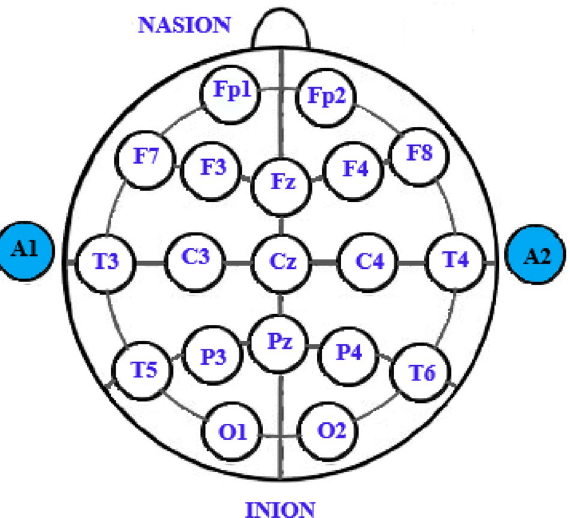
Figure 7. The schematic image of 21 electrodes on the head (using Paint 3D version 6.1907.29027.0 https:// apps. micro soft. com/ store/ detail/ paint- 3d/ 9NBLG GH5FV 99? hl= en- us& gl=